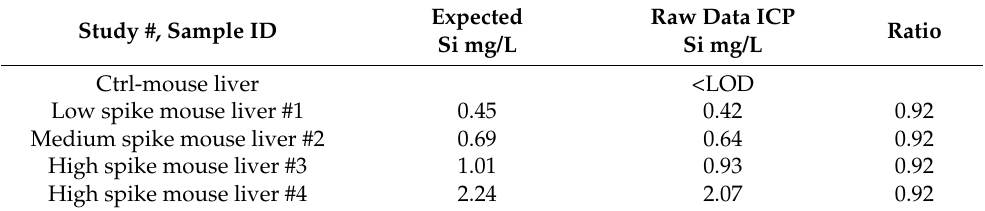
Table 6. Recovery ratios for mouse liver after digestion in HNO 3 /H 2 O 2 .